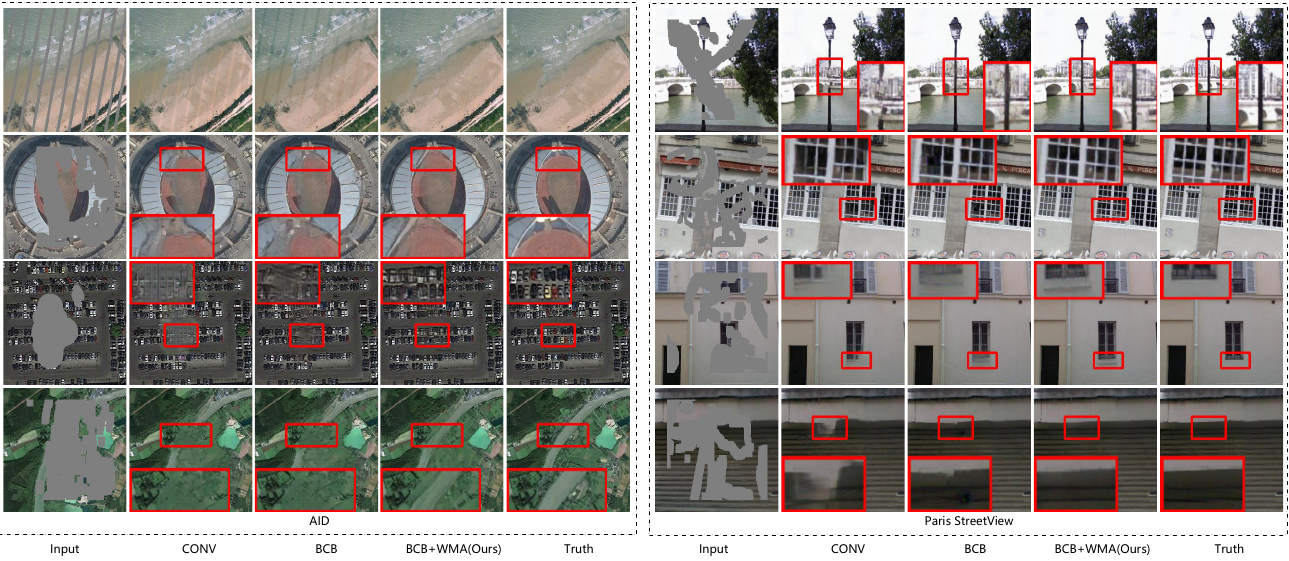
Figure 9. Ablation qualitative results of the AID and Paris StreetView datasets. Local details are displayed in the red